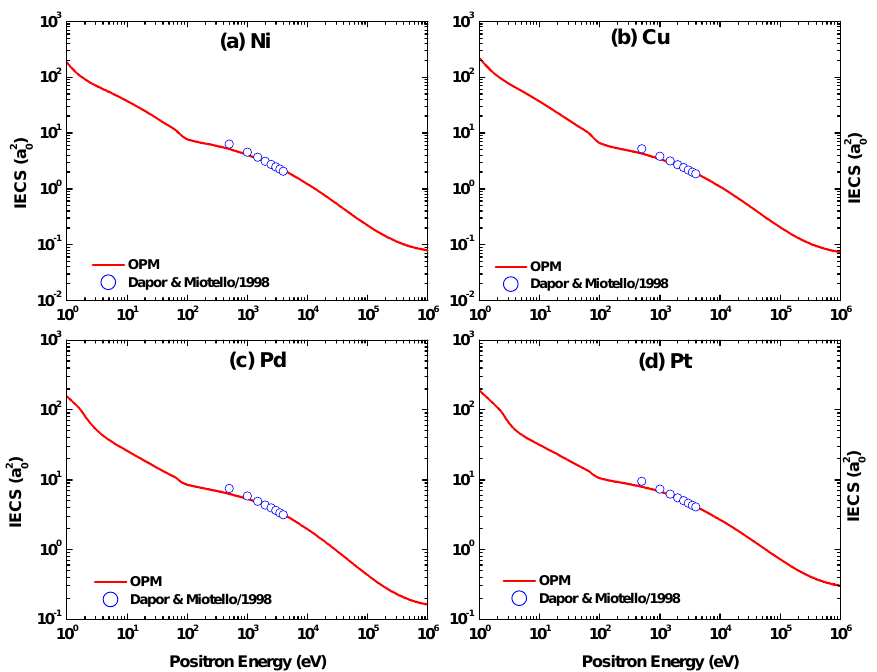
Figure 36. The present OPM calculations of the IECS for positron impact scattering from ( a ) Ni 58 , ( b ) Cu 63 , ( c ) Pd 108 , and ( d ) Pt 196 in comparison with the results of Dapor and Miotello [50].